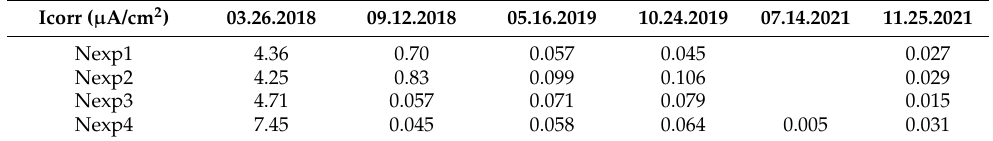
Table 8. Corrosion rate values obtained in control points with Gecor 10 over the time of the study. Icorr ( µ A/cm 2